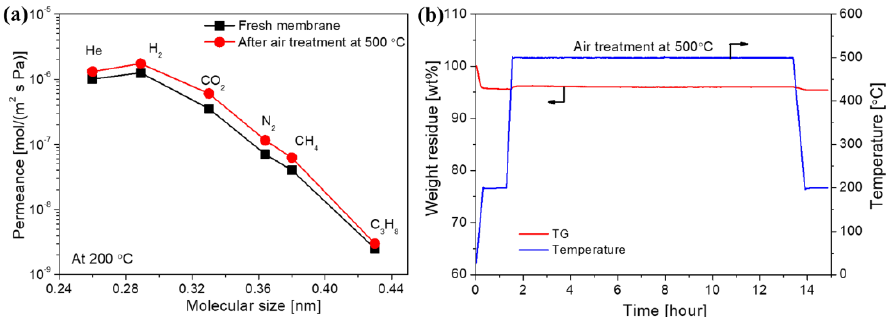
Figure 25. ( a ) Single-gas permeance at 200 °C for a PCS-derived membrane before and after air treatment at 500 °C; ( b ) time-course changes in the weight of PCS-derived SiC powder in air at 500 °C following 12 h. The powder was prepared under the same conditions as the membrane. Adapted from [72] with permission from Elsevier.